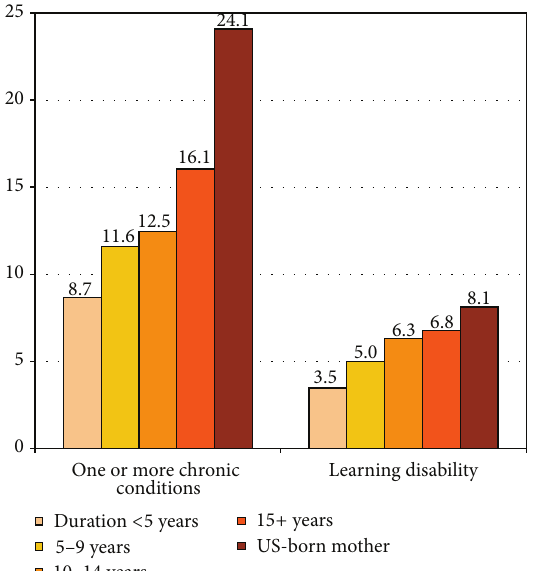
Figure 6: Prevalence (%) of chronic conditions and learning disability among children aged < 18 years by mother’s duration of residence in the United States, 2007. Source: The 2007 National Survey of Children’s Health ( 𝑁 = 91, 642 ).